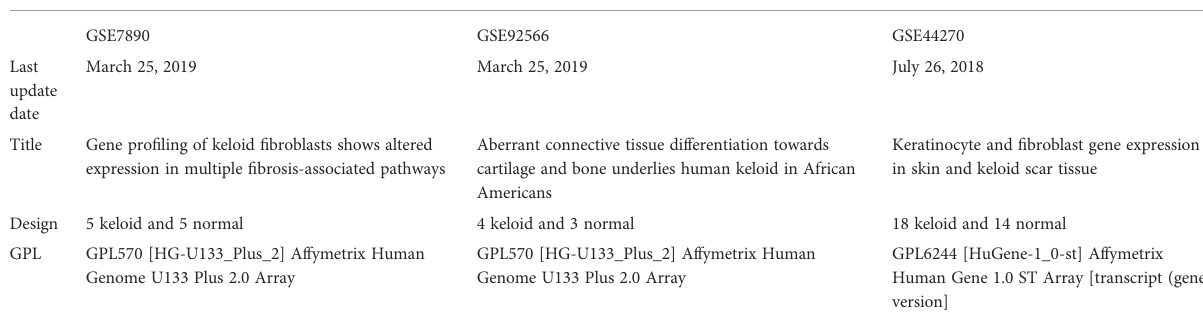
TABLE 1 Details of